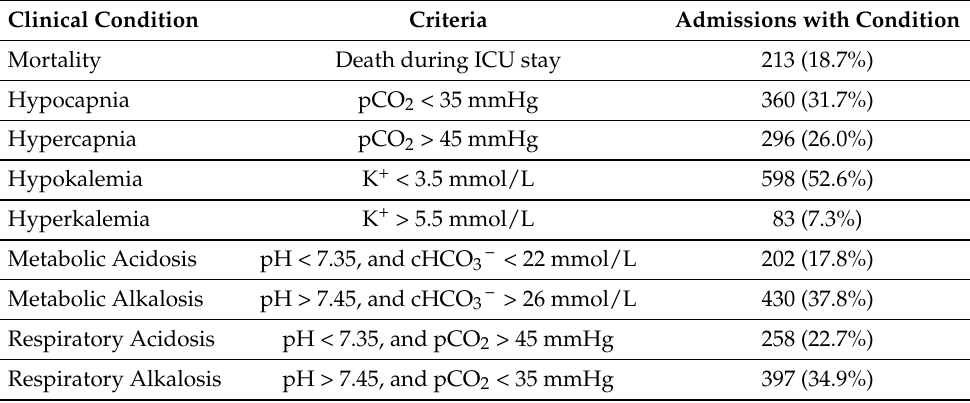
Table 2. Criteria and statistics of clinical